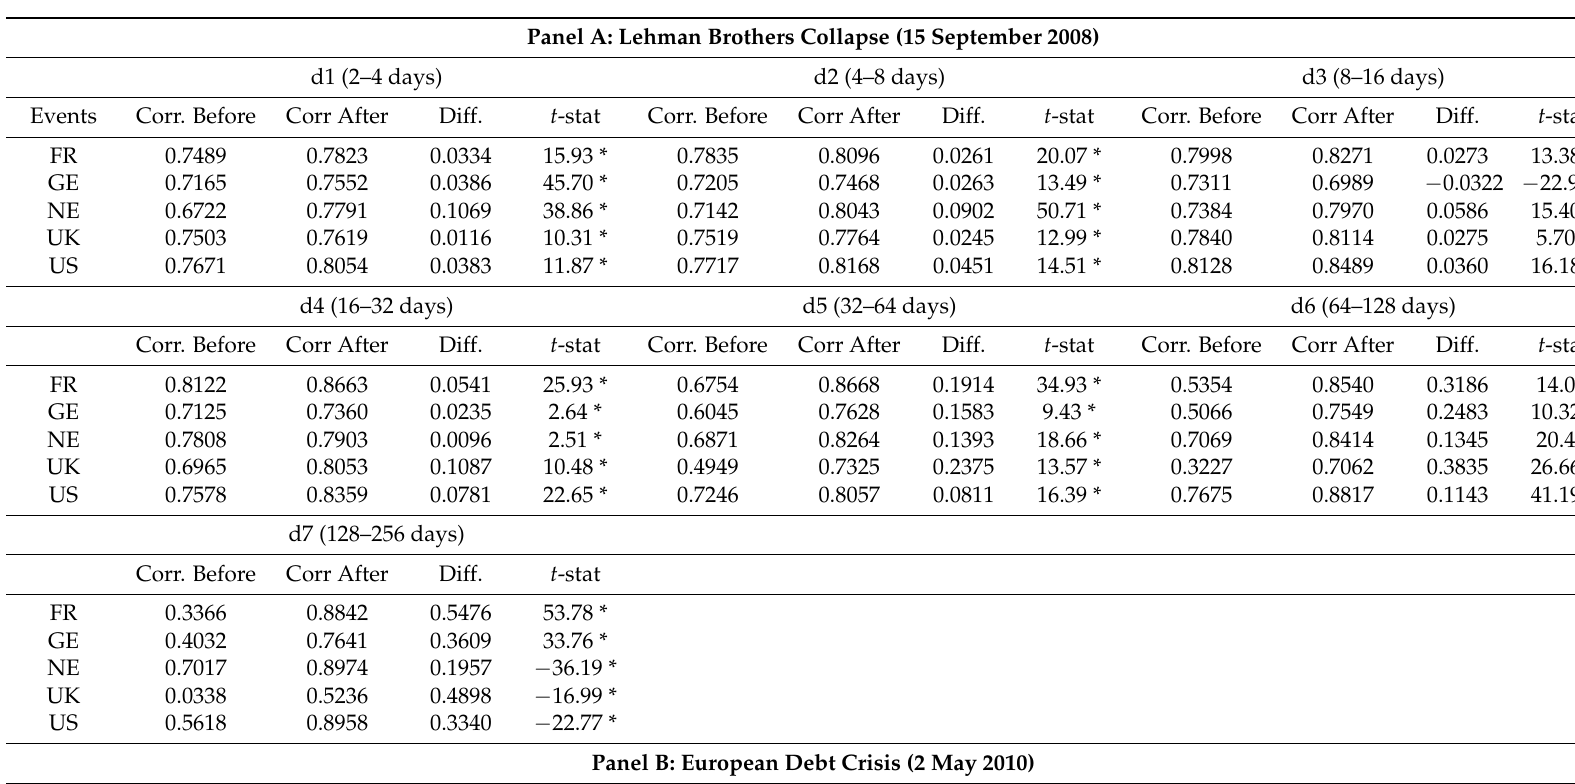
Table 5. Average rolling wavelet real estate–stock correlations (250 days window) and t-tests before and after the